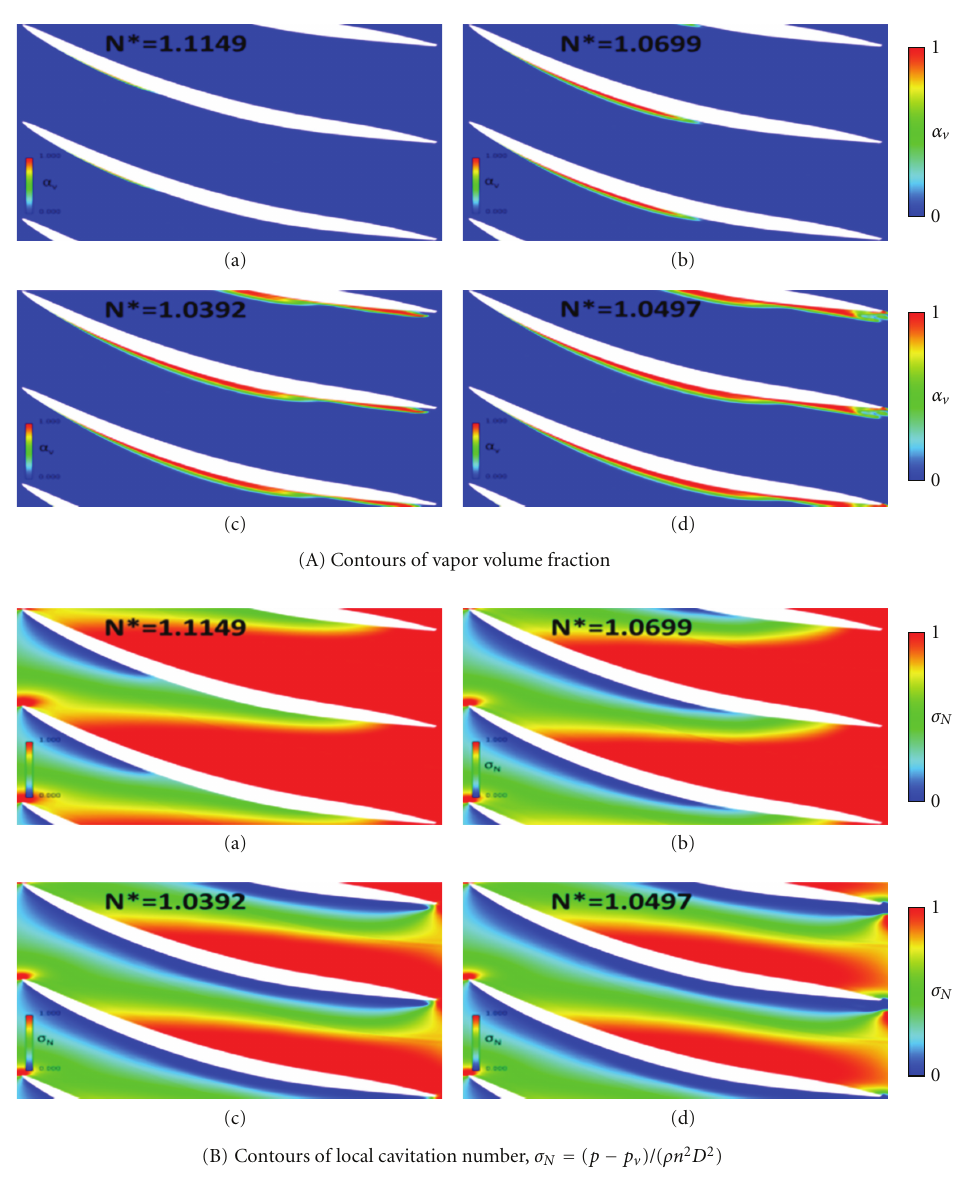
Figure 9: Computational results, constant radius cut through rotor solution, r/R shroud = 0 . 53 (near hub), Q ∗ = 0 . 825. Results at each of four conditions, (a) ( N ∗ = 1 . 1149) (b) ( N ∗ = 1 . 0699) (c) ( N ∗ = 1 . 0392) (d) ( N ∗ = 1 . 0497), prior to and after breakdown. (A) Volume fraction contours. (B) Local cavitation